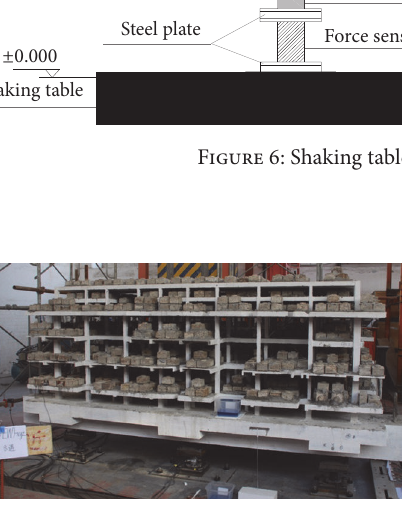
Figure 7: Photograph of shaking table test setup for isolated